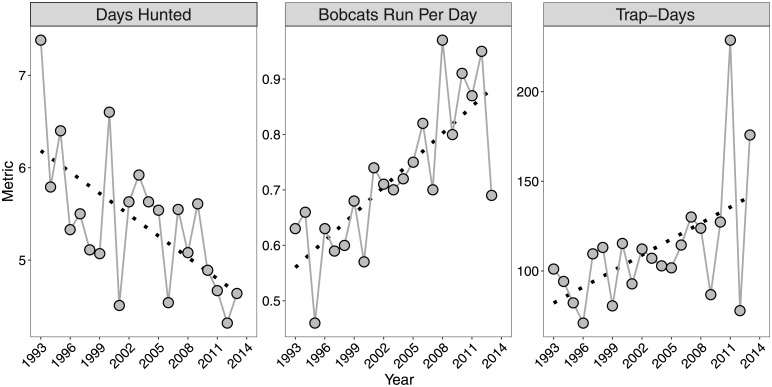
Annual variation in effort and success by bobcat hunters (days hunted and bobcats chased per day) and trappers (trap-days–number of days trapped multiplied by number of trap sets) in Wisconsin from 1993–2013.The dashed lines are estimated fits from linear regression models.